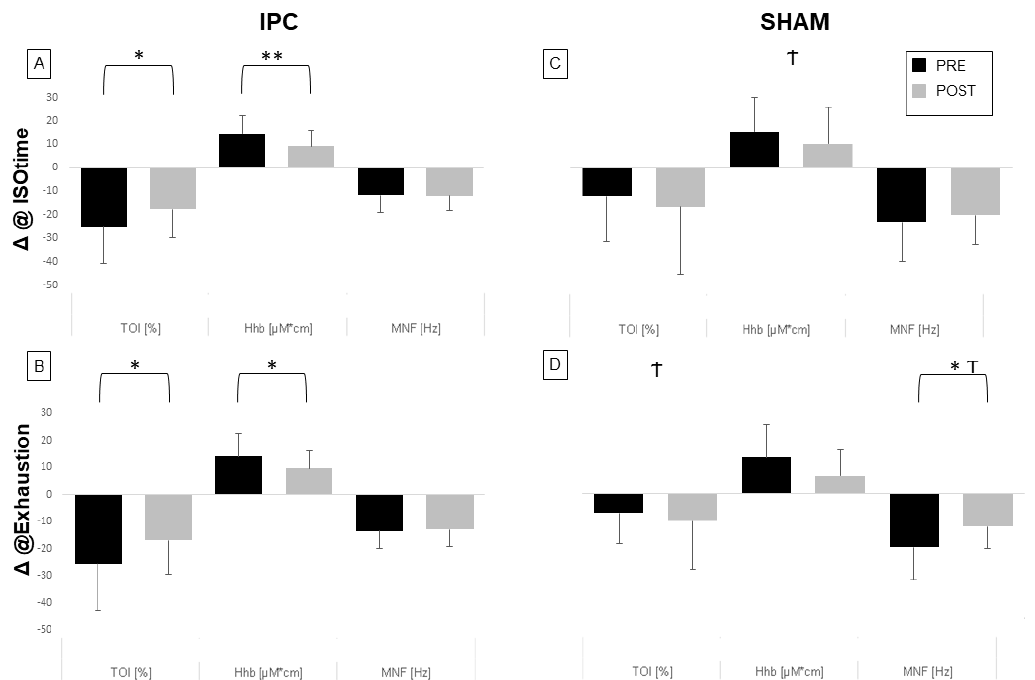
Figure 5. Average changes in TOI, HHb, and MNF during exercise. The changes are calculated at ISOtime ( A , C ) and at exhaustion ( C , D ) with respect to the first contraction for the two groups IPC ( A , B ), and SHAM ( C , D ) and pre- (black) and post- (gray) treatment conditions. * = pre vs. post, p < 0.05; ** = pre vs. post, p < 0.01. Average effects of treatment (post—pre) were compared between IPC and SHAM: † = p <